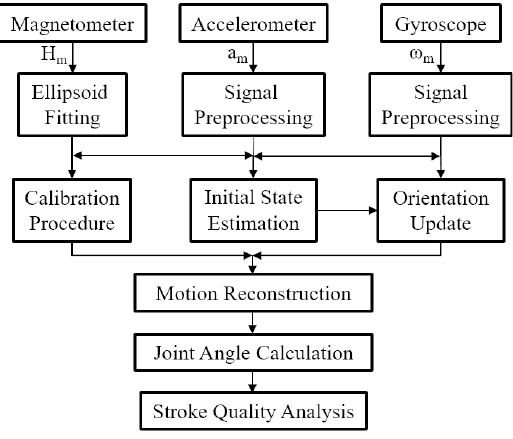
Figure 6. The schematic overview of the proposed inertial motion capture